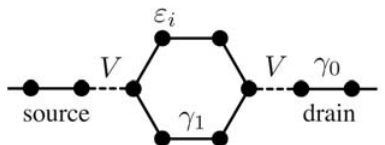
Figure 1. A benzene-like structure (molecule) attached to the